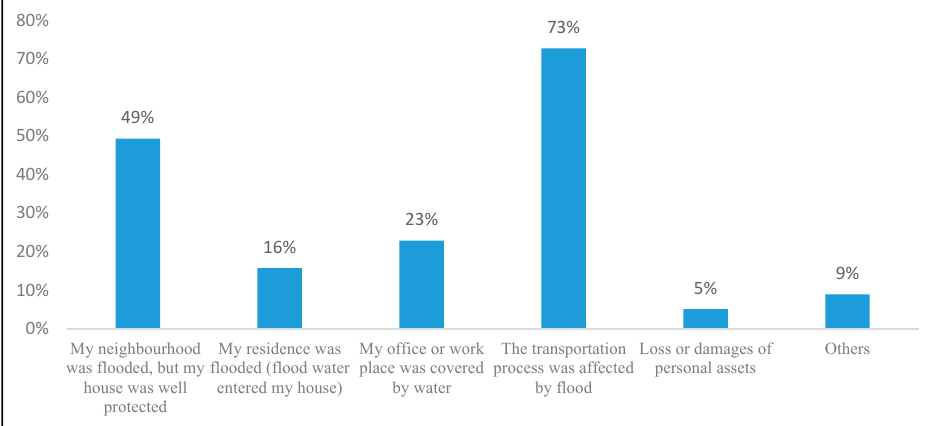
Figure 2. Impacts of urban floods as perceived by survey